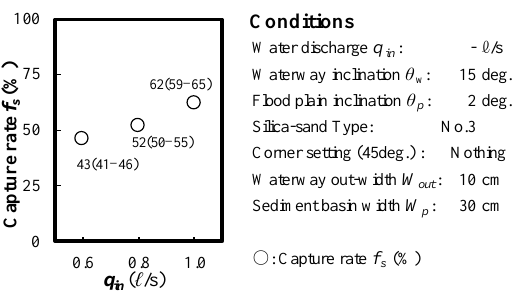
Figure 8. Effects of changes in the supply flow q in rate on the sediment catch rate in the sediment retarding basins.